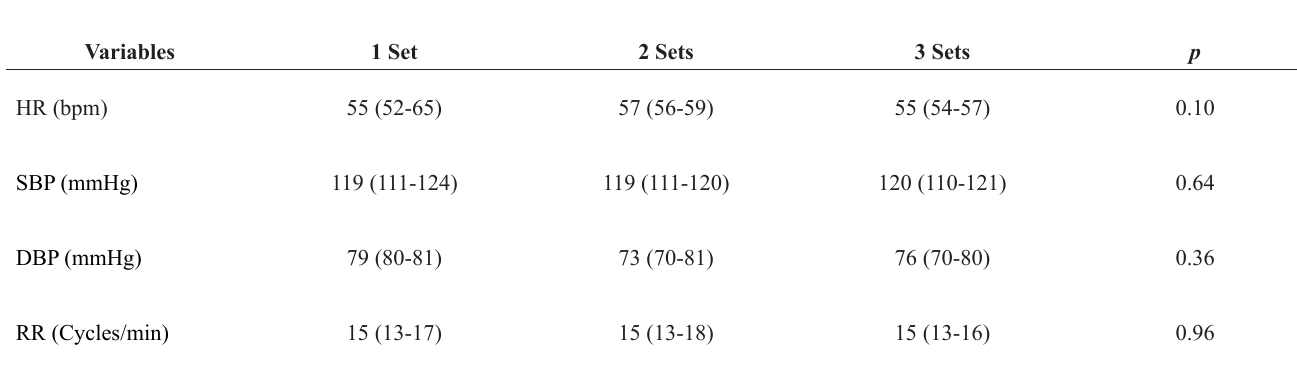
Table 1- Median (interquartile range) cardiovascular and respiratory pre-exercise measurements assessed in the three occasions.